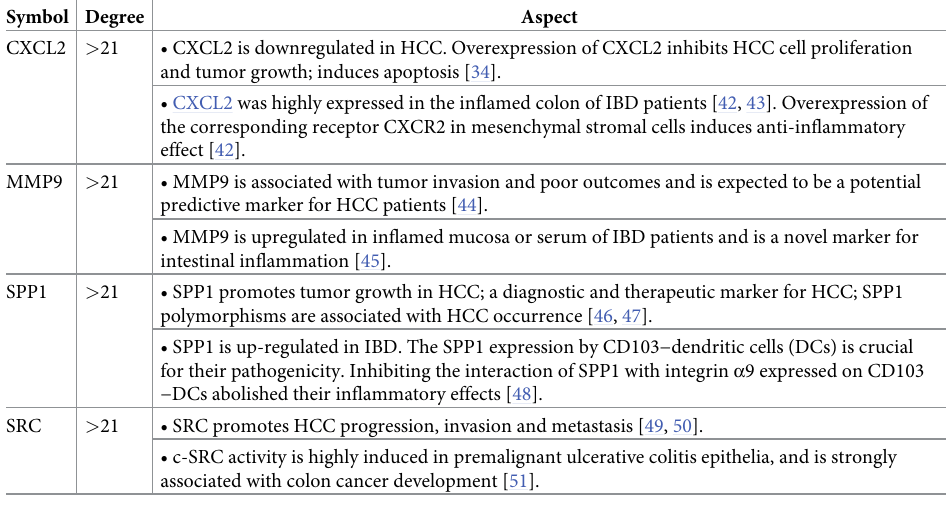
Table 1. Overview of four hub proteins obtained from the protein-protein interaction network in HCC and